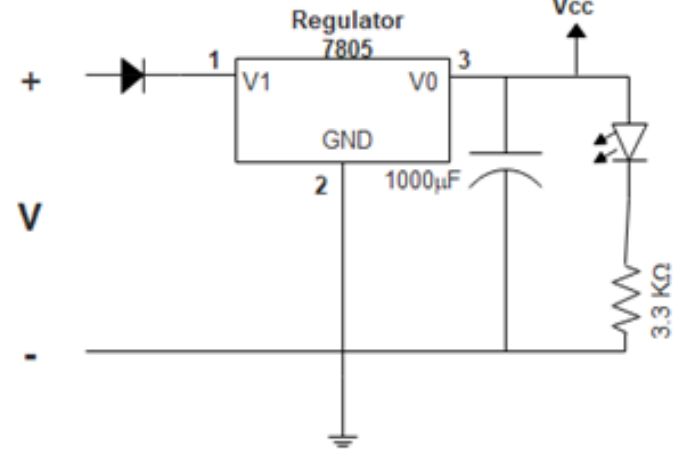
Fig. 2. Voltage Regulator